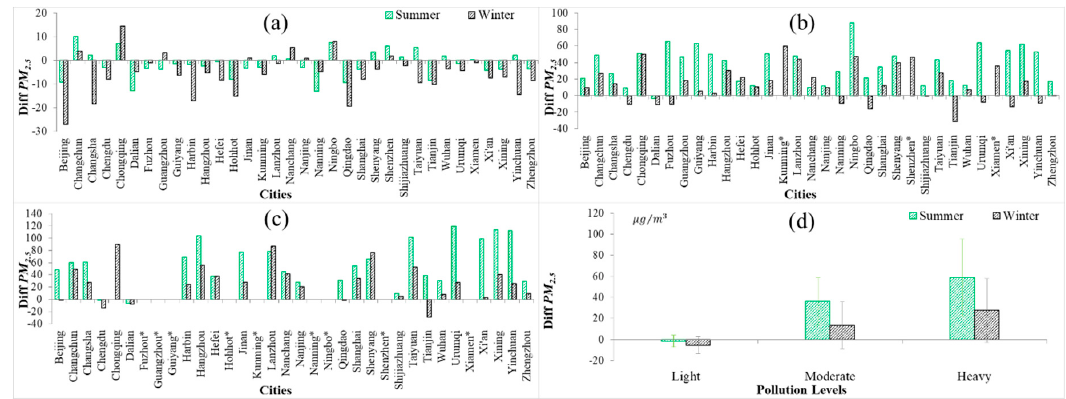
Figure 7. PM 2.5 di ff erences (Di ff PM 2.5 = PM 2.5 − urban − PM 2.5 − rural , unit: µ g / m 3 ) in di ff erent PM 2.5 Figure 7. PM (cid:2870).(cid:2873) differences ( Diff 𝑃𝑀 (cid:2870).(cid:2873) = 𝑃𝑀 (cid:2870).(cid:2873)(cid:2879)(cid:3048)(cid:3045)(cid:3029)(cid:3028)(cid:3041) − 𝑃𝑀 (cid:2870).(cid:2873)(cid:2879)(cid:3045)(cid:3048)(cid:3045)(cid:3028)(cid:3039) , unit: μ g / m 3 ) in different PM (cid:2870).(cid:2873) concentration bins based on surface observations: ( a ) 0–50 µ g / m 3 (light pollution), ( b ) 100–150 µ g / m 3 concentration bins based on surface observations: ( a ) 0–50 μ g / m 3 (light pollution), ( b ) 100–150 μ g / (moderate pollution), and ( c ) > 200 µ g / m 3 (heavy pollution). ( d ) the mean PM 2.5 spatial di ff erences in m 3 (moderate pollution), and ( c ) >200 μ g / m 3 (heavy pollution). ( d ) the mean 𝑃𝑀 (cid:2870).(cid:2873) spatial differences all cites for di ff erent PM 2.5 levels. Green and black bars represent summertime and wintertime PM 2.5 in all cites for different 𝑃𝑀 (cid:2870).(cid:2873) levels. Green and black bars represent summertime and wintertime di ff erences, respectively. Asterisks mark those cities with insu ffi cient numbers of PM 2.5 differences, respectively. Asterisks mark those cities with insufficient numbers of samples.